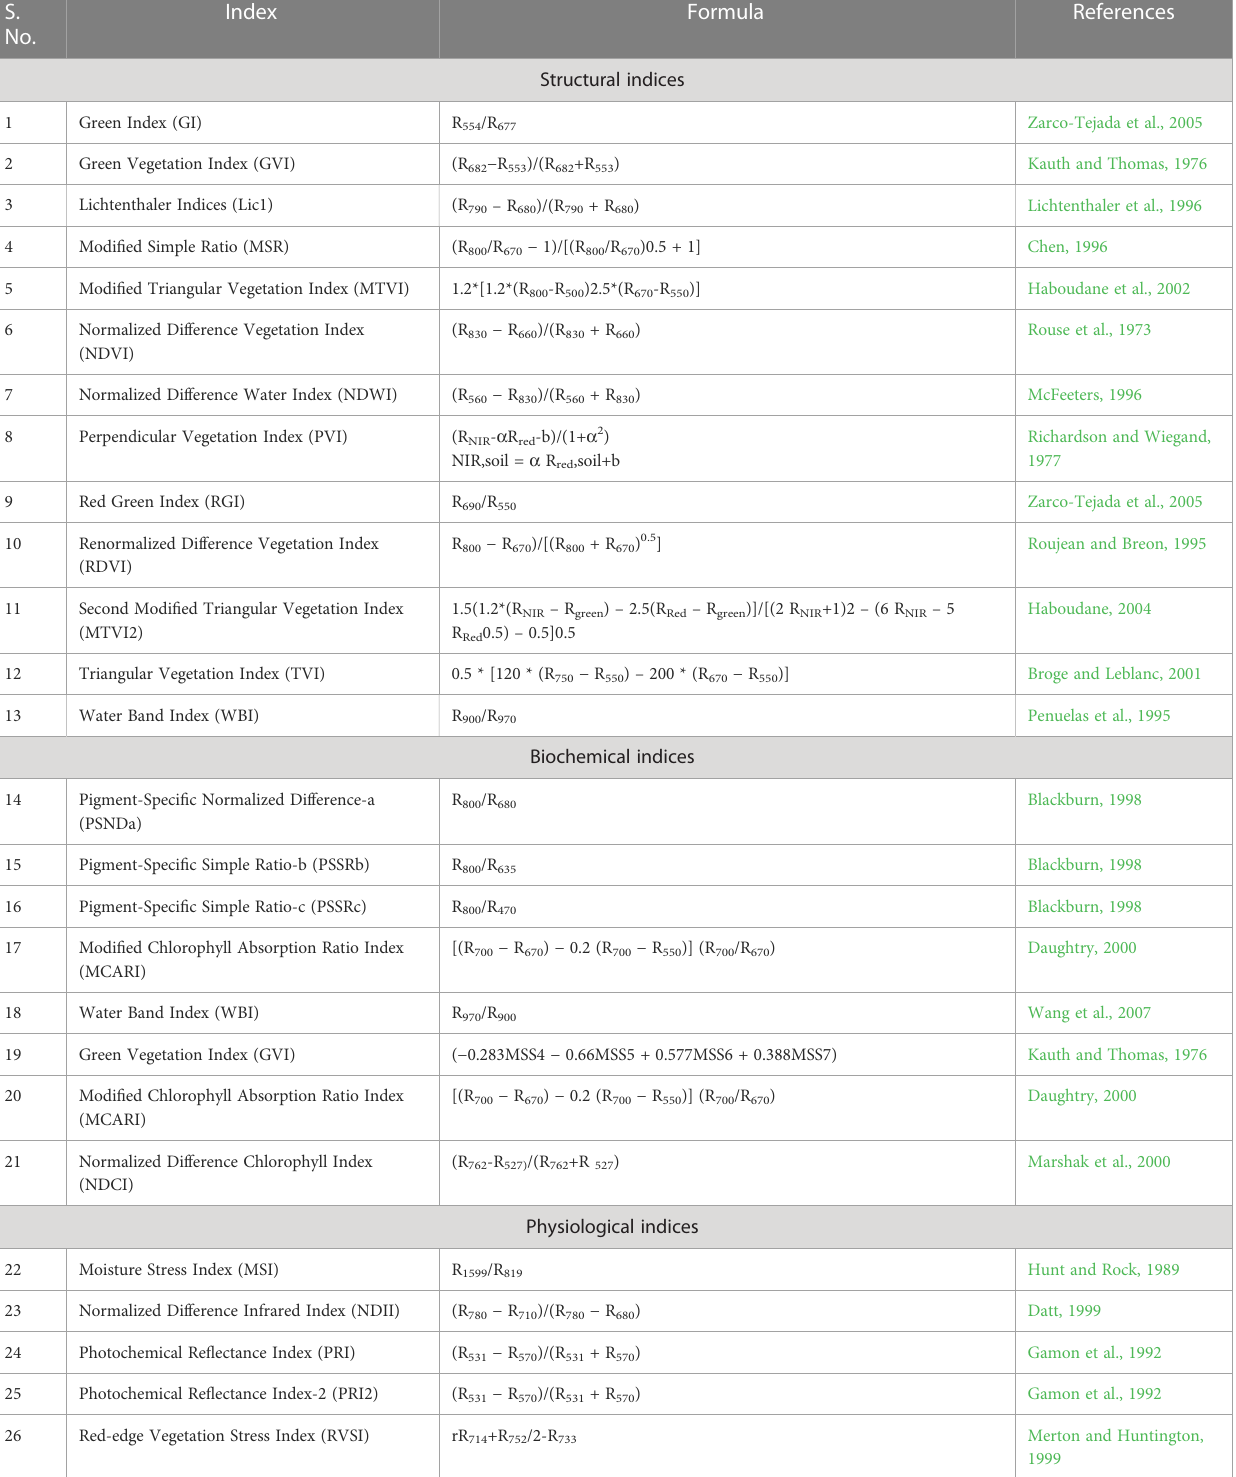
TABLE 3 Details of spectral indices used for regression model development for disease severity